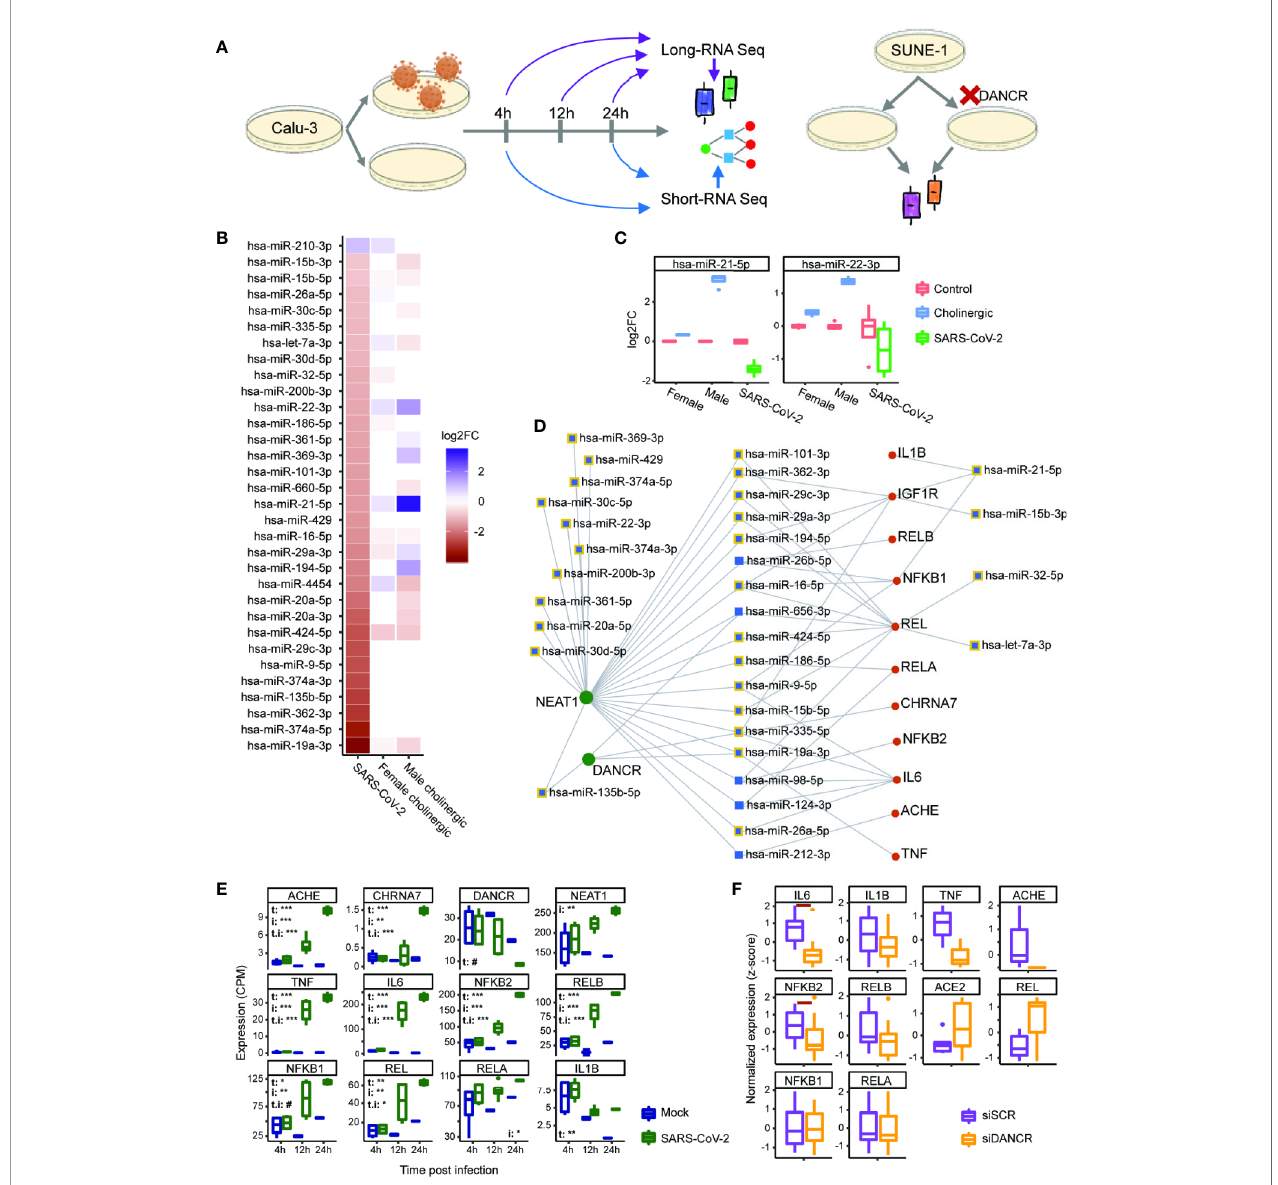
FIGURE 6 | DANCR and NEAT1 interlink with in fl ammatory transcripts and DE miRs both in SARS-CoV-2 infection and in differentiated cholinergic neurons. (A) Long RNA-sequencing was conducted on Calu-3 epithelial lung cells infected or not with SARS-CoV-2 and harvested 4, 12, and 24 h post infection. Short RNA-sequencing was performed on 4- and 24-h samples. Additionally, neuron progenitor cells (SUNE-1) were treated with siDNACR (to execute DANCR knockdown) or with si-Scramble (siSCR) for control and were sequenced for long RNAs. (B) 32 miRs were DE in infected Calu-3 cells (left column) and were ordered from largest positive to negative fold change (FC; top; bottom). Thirteen and 17 of these miRs were DE under cholinergic differentiation in female and male neuroblastoma cells (LA-N-2; middle column and LA-N-5; right column). Color coding represents log2 of FC with red standing for negative FC of infected/uninfected or differentiated/non-differentiated and blue — for positive. n=4 for each condition. (C) Boxplot representation for two miRs from B. Red stands for all control conditions (untreated \ uninfected); blue — for cholinergic differentiation (CNTF) and green – for SARS-CoV-2 infection. Expression is normalized to the mean of control in each group (female, male and SARS-CoV-2-infection). (D) A network showing miRs (blue) targeting either DANCR or NEAT1 (green) and at least one in fl ammatory transcript (red). Squares representing miRs that were DE under SARS-CoV-2 infection are shown with yellow margins. (E) Boxplots showing Calu-3 infected (green) and control (blue) cells in three different timepoints. Upper-left corner shows signi fi cance for corrected (FDR) ANOVA test results (# = p<0.065; * = p<0.05; ** = p<0.01; *** = p<0.001) where t stands for “ time ” (i.e. 4, 12, or 24 h), i — for “ infection ” (infected or uninfected) and “ t.i ” for the combination of time and infection. If not stated — insigni fi cant. n=3 for each condition. (F) SUNE-1 neuron progenitor cells treated with siDANCR (orange) or siSCR (purple). Red horizontal lines indicate p<0.05 (t. test, FDR). n=3 for each